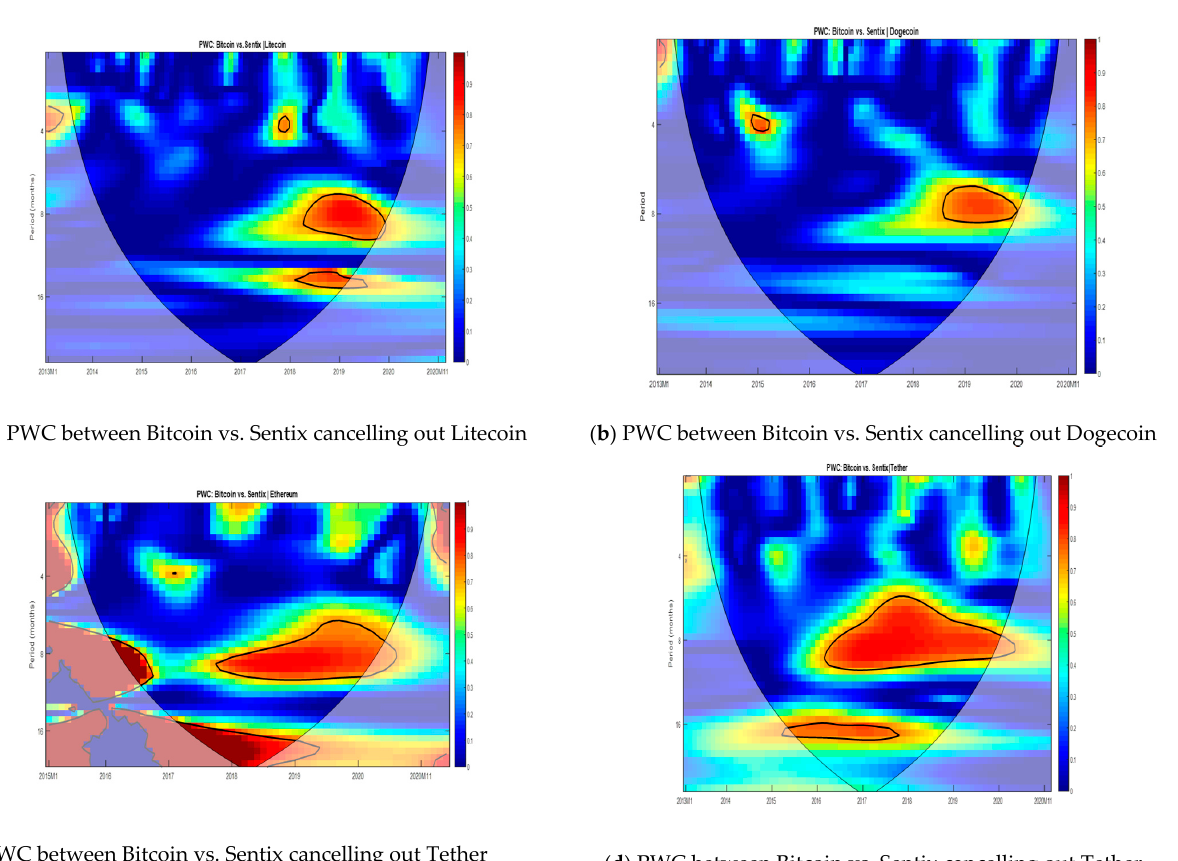
Figure 3. The partial wavelet coherencies between Bitcoin and the Sentix Investor Confidence index and cryptocurrencies. The black contour recognizes the regions in which the spectrum is significant at the 5% level against red noise. The cone of influence (COI) is designated by the lighter shade, which delimits the high ‐ power regions. The horizontal and vertical axes denote time and scale bands, respectively. Overall, when looking at the PWC plots, we show that highest coherencies are spread in the middle